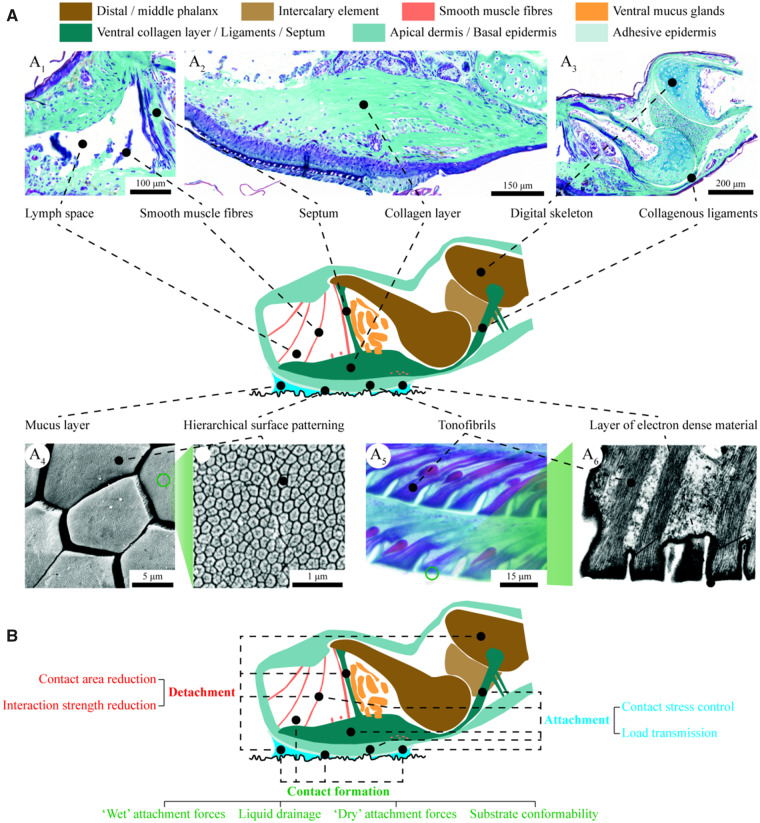
Schematic depiction of a tree frog’s toe pad in lateral view showing (A) structures and materials relevant to attachment (A1–3 lateral histographs, A4 ventral scanning electron micrographs, A5 lateral histograph, A6 lateral transmission electron micrograph), and (B) associated mechanisms of contact formation, attachment, and detachment (see main text for details). Micrographs modified with permission according to A1–3,5  Langowski et al. (2018b); A4  Federle et al. (2006); A6  Ernst (1973).